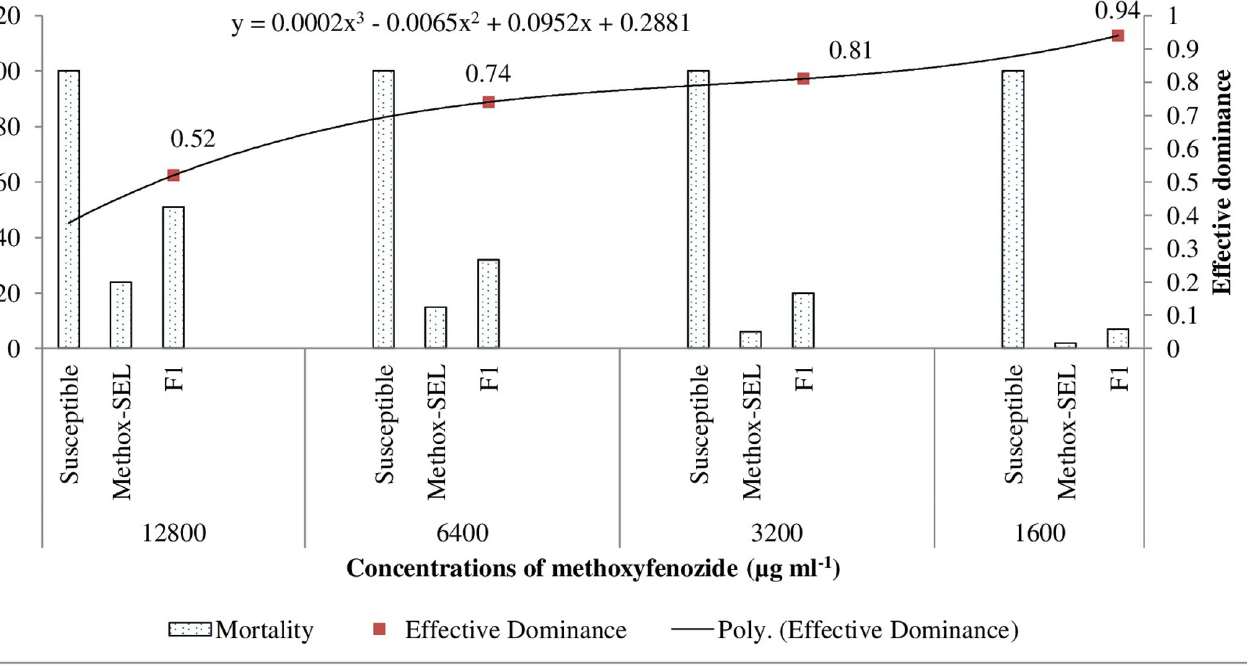
PLOS ONE | https://doi.org/10.1371/journal.pone.0265304 March 22,